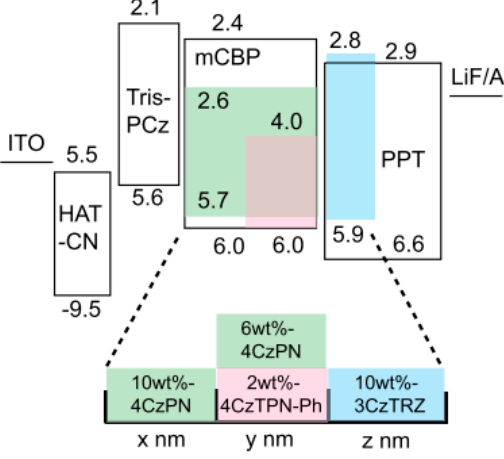
Figure 15. The WOLED structures and energy level diagram. Reproduced from Reference [156].